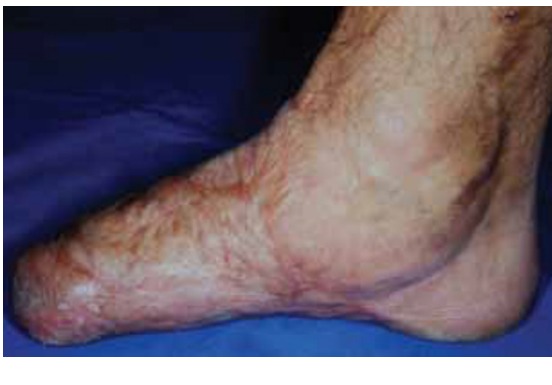
Figure 6. Clinical case 2 . The sensibility of the heel was preserved, so the patient was able to walk after the